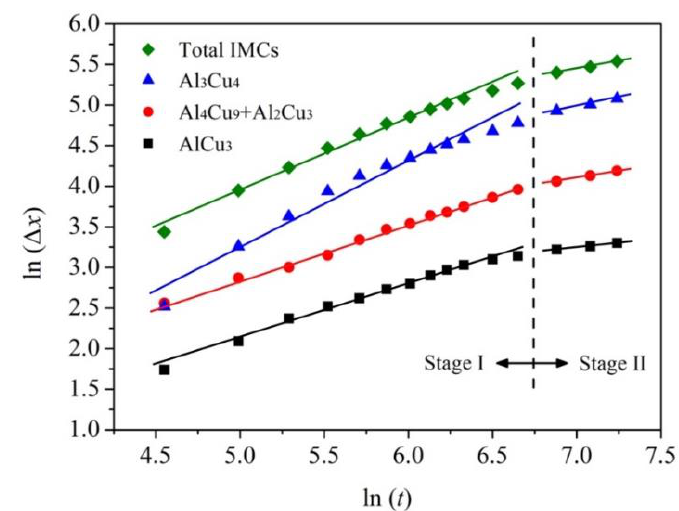
Figure 9. The relationship between ln (Δ x ) and ln ( t ) for the IMCs layers. Table 2. The n values for IMCs layers at different stage. Layer.